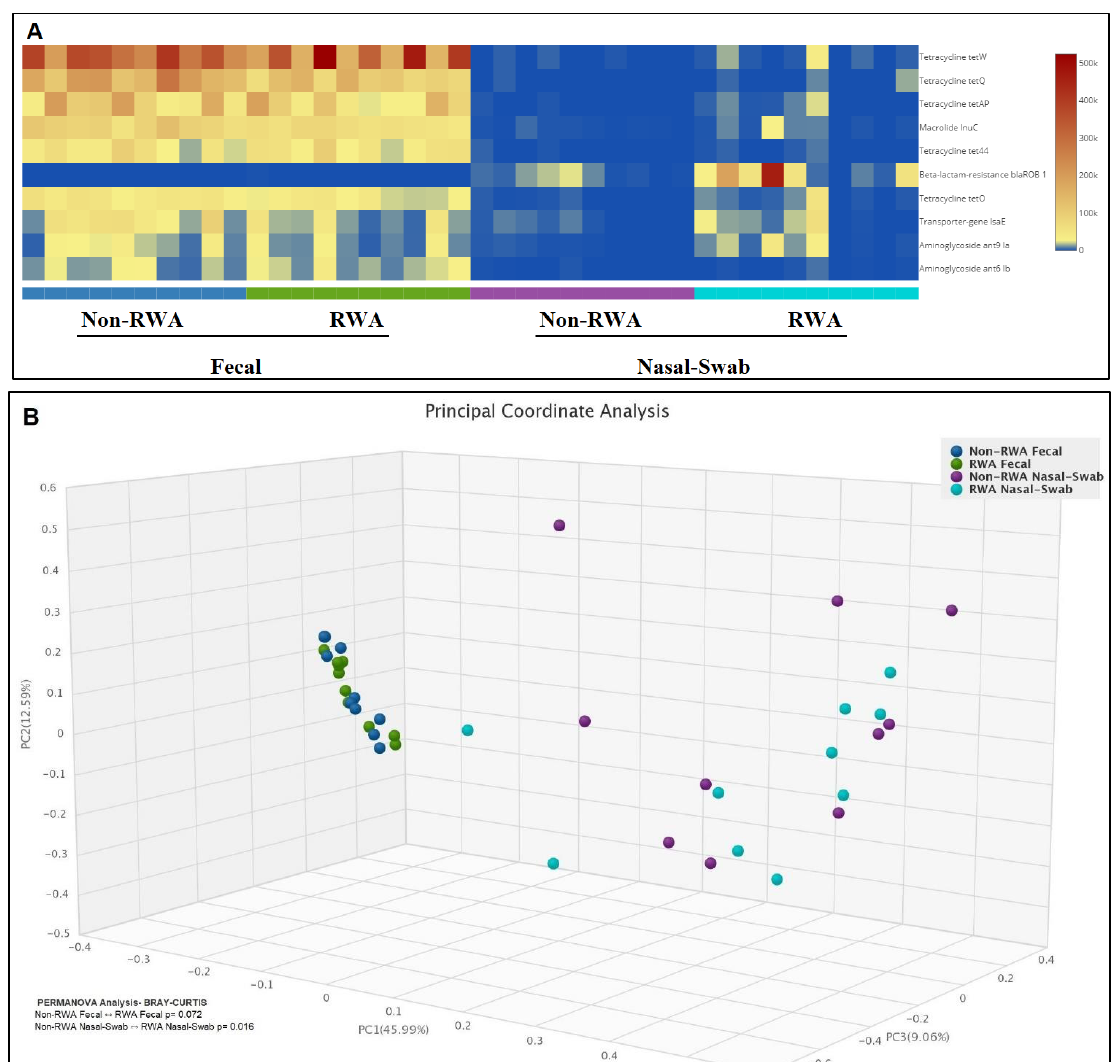
Figure 5. Gene frequency heat map comparative analysis of sow feces and nasal swabs from non-RWA vs. RWA barns, showing the frequencies of the 10 most abundant ARGs ( A ). PCoA and ordination PERMANOVA analysis of the RWA vs. non-RWA resistome profiles from sow feces and nasal swab samples ( B ).